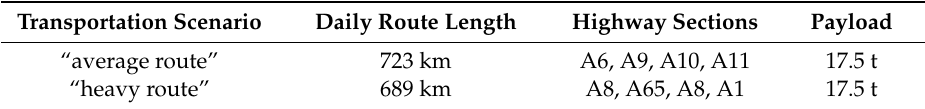
Table 3. Transportation scenarios containing different